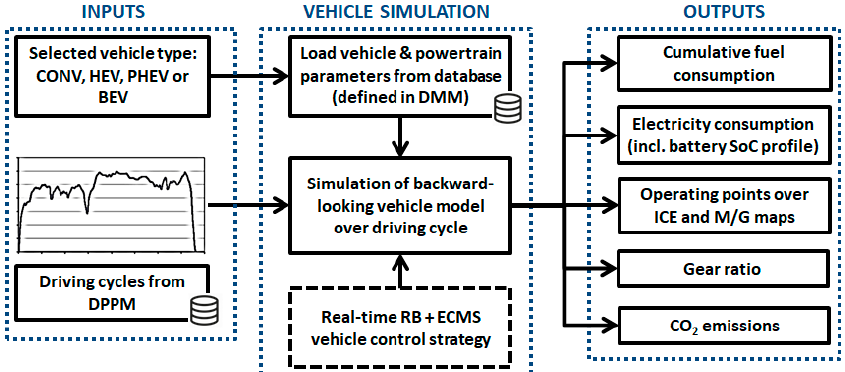
Figure 8. Flowchart of E-Bus Simulation Module (EBSM).